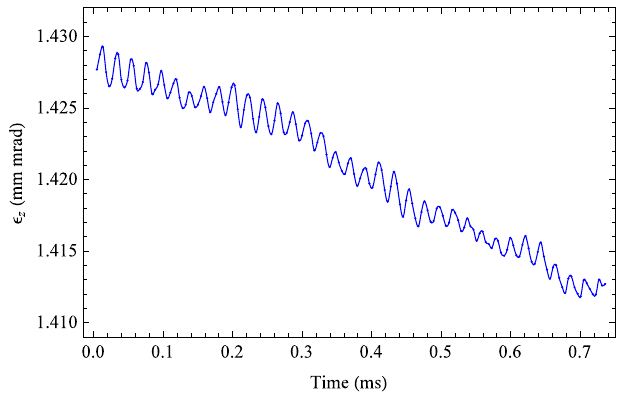
FIG. 15. The longitudinal emittance of the C þ 6 ions beam cooled with an electron beam of shorter bunch length and larger radius. The electron beam current is 15 mA and the longitudinal magnetic field in the cooling section is B